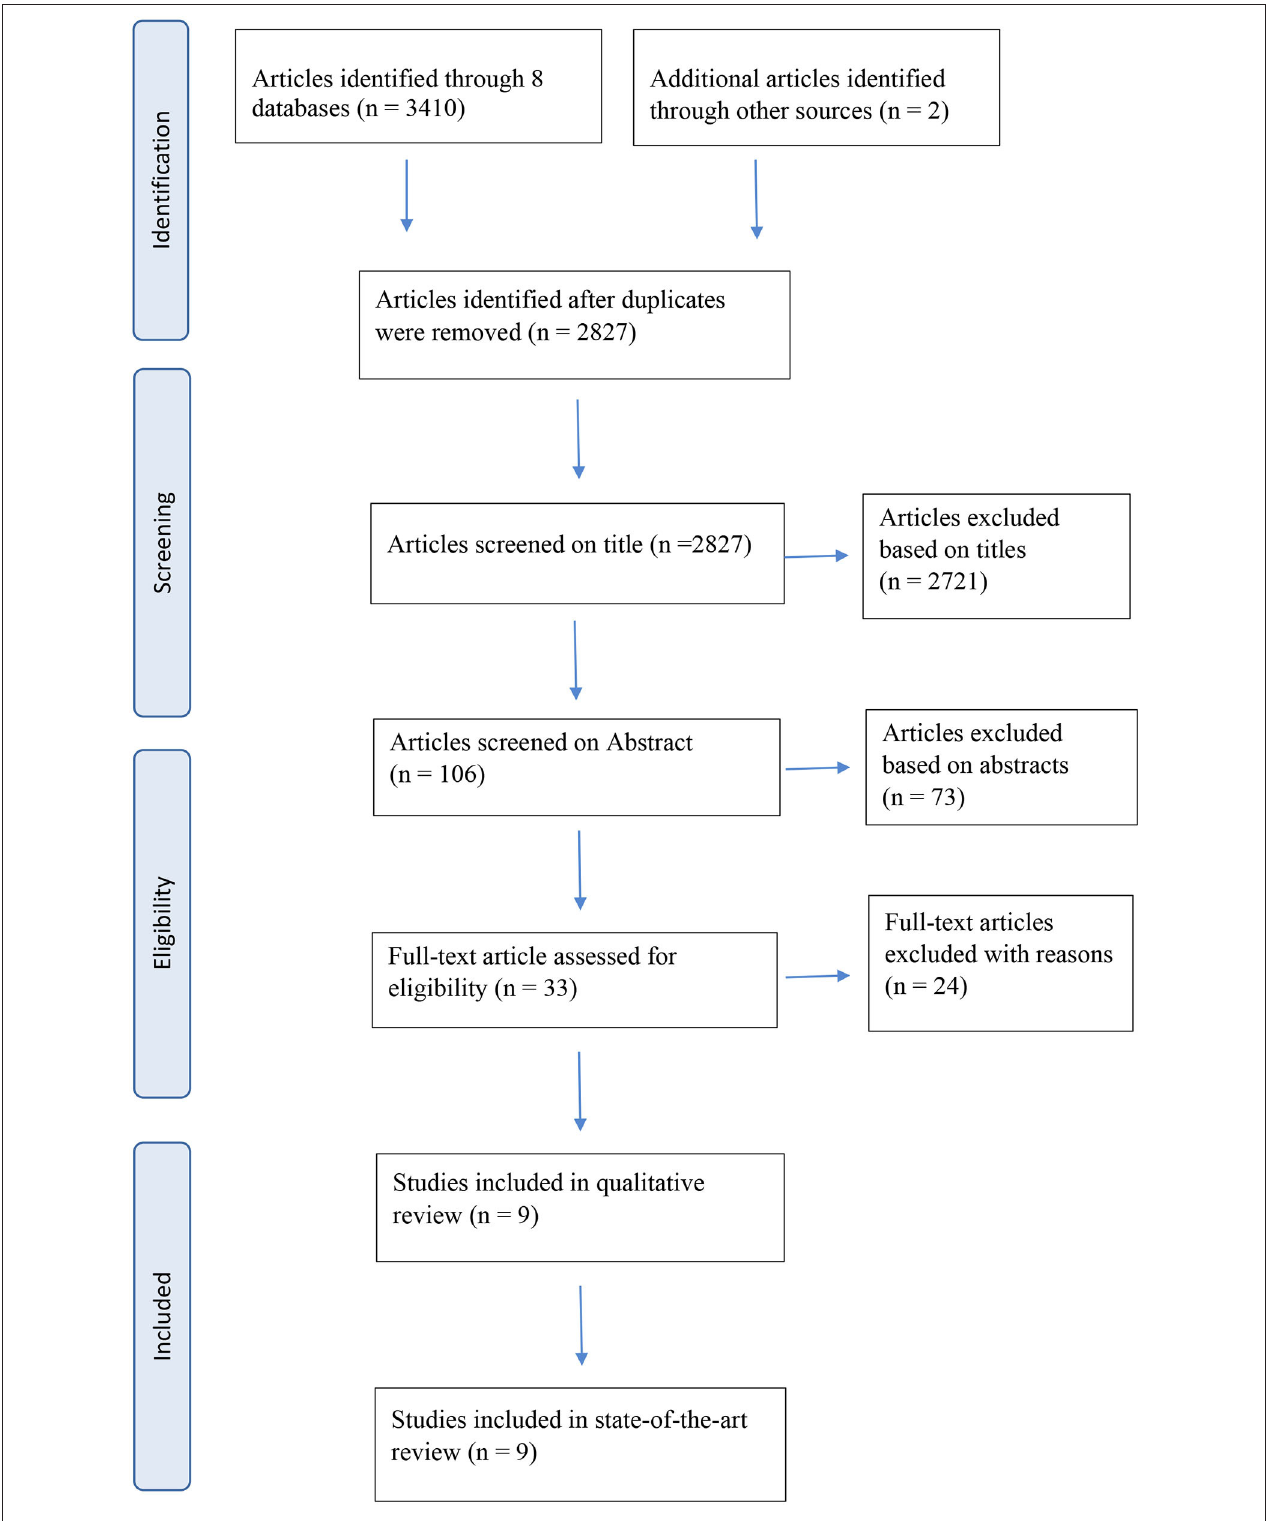
FIGURE 1 | Flow Diagram depicting identification and screening